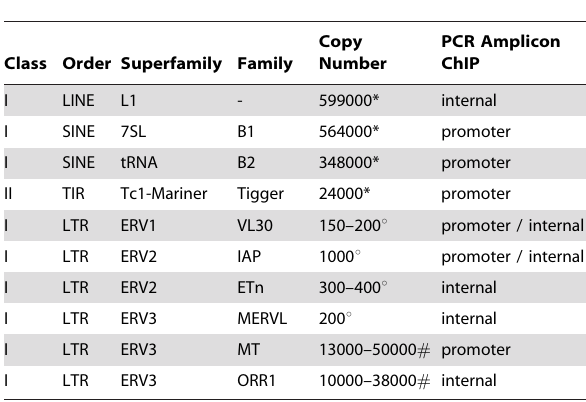
Table 1. Transposable elements analysed in this